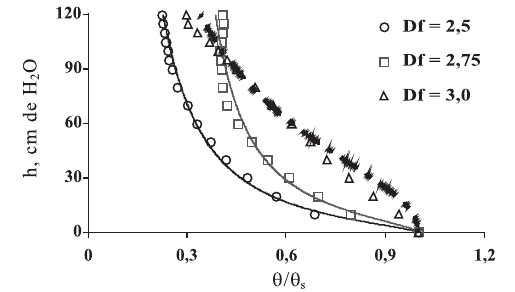
2. CRs para as amostras arenosas cujas